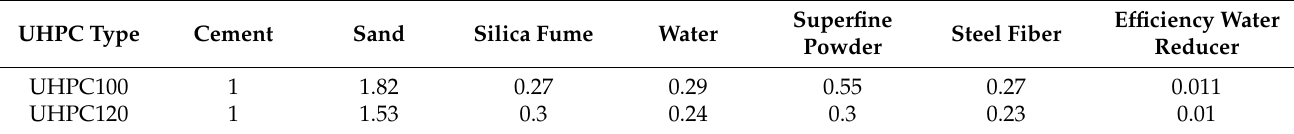
Table 2. Mix proportions of UHPC material.